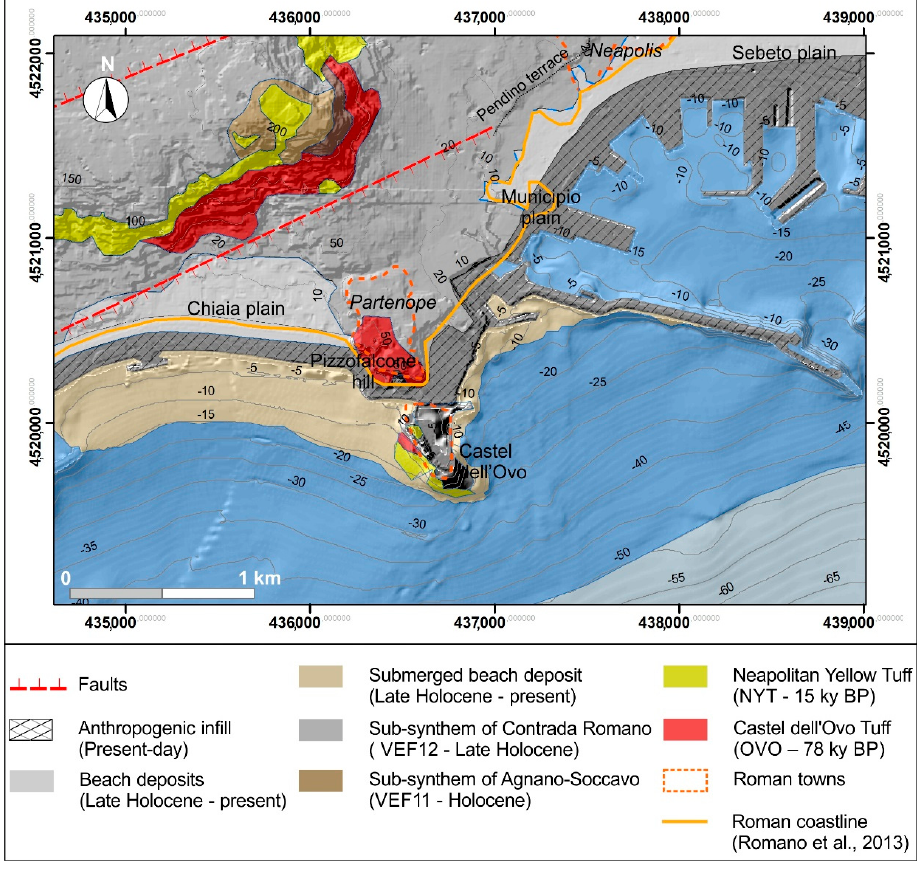
Figure 2. Geological map of the study area (Modificated from [12]). The shaded relief was obtained from the DTM, calculated by interpolating the 2013 LIDAR data provided by the Ministry of